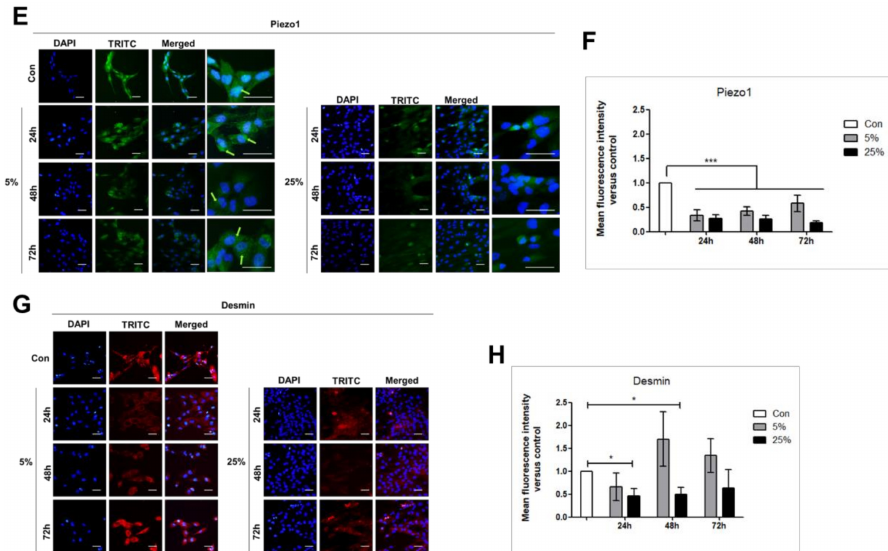
Figure 1. Cyclic stretch affects cardiomyocyte alignment and Piezo1 distribution. ( A ) Illustration showing cardiomyocytes seeded on stretchable polydimethylsiloxane PDMS membrane, stretched in one direction or uniaxial. ( B ) Cell number was counted after subjected to 5%, and 25% 24 h stretching. ( C , D ) Cell alignment after 24 h was measured using ImageJ. ( E , F ) Expressions of the stretch-activated ion channel Piezo1. ( G , H ) and cardiomyocyte characteristic marker Desmin analyzed by immunofluorescence assay after 24 h, 48 h, and 72 h of stretching. Scale bar = 100 µ m. *, p value < 0.05, ***, p value <